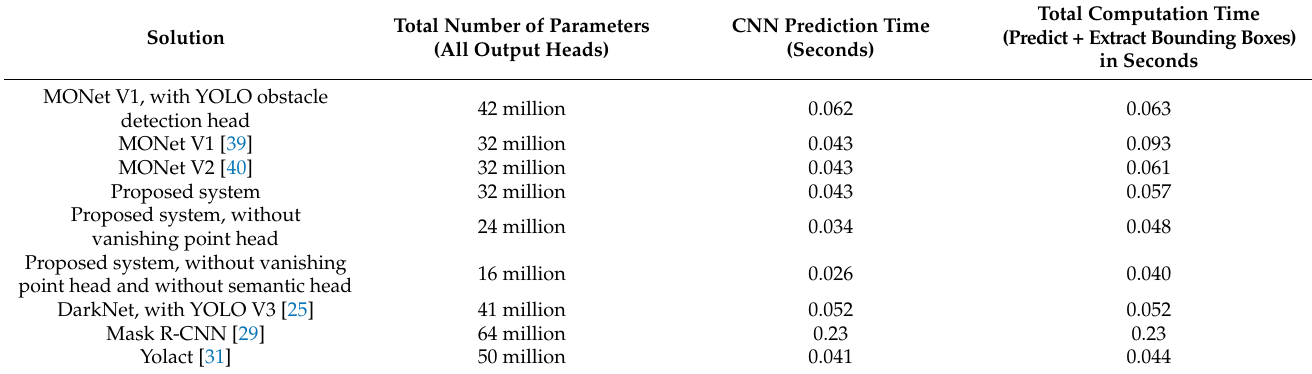
Table 3. CNN comparisons.